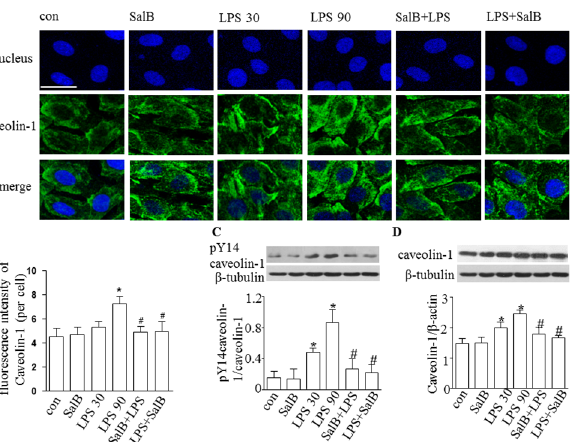
Fig 3. Effect of SalB on caveolin-1 in HUVECs subjected to LPS challenge. A: Images of confocal microscopy showing the distribution of caveolin-1 in HUVECs in different groups. Bar = 25 μ m. B: Quantitative assessment of caveolin-1 in HUVECs. C: Western blot showing the protein level of phosphorylation of caveolin-1 (Tyr14) and the ratio of phosphorylated caveolin-1 (Tyr14) to caveolin-1 in HUVECs in different groups. D: Western blot showing the protein level of caveolin-1 and the ratio of caveolin- 1/ β -tubulin in HUVECs in different groups. Data were expressed as mean ± SE of 6 independent experiments. * p < 0.05 vs. control group, # p < 0.05 vs. LPS 90 group. One-way analysis of variance (ANOVA) with Turkey post hoc test was